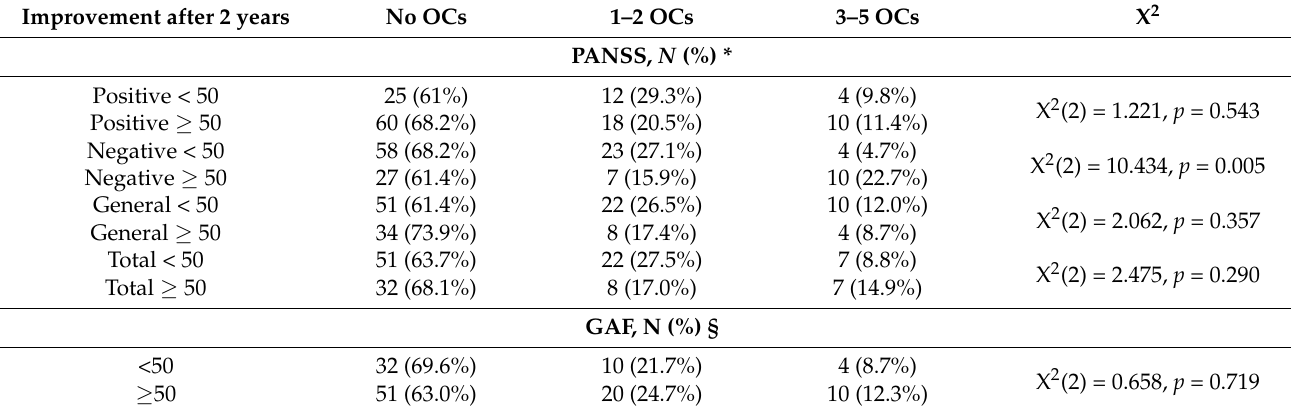
Table 3. Association between OCs and response to treatment and functioning after 2 years ( n = 120).